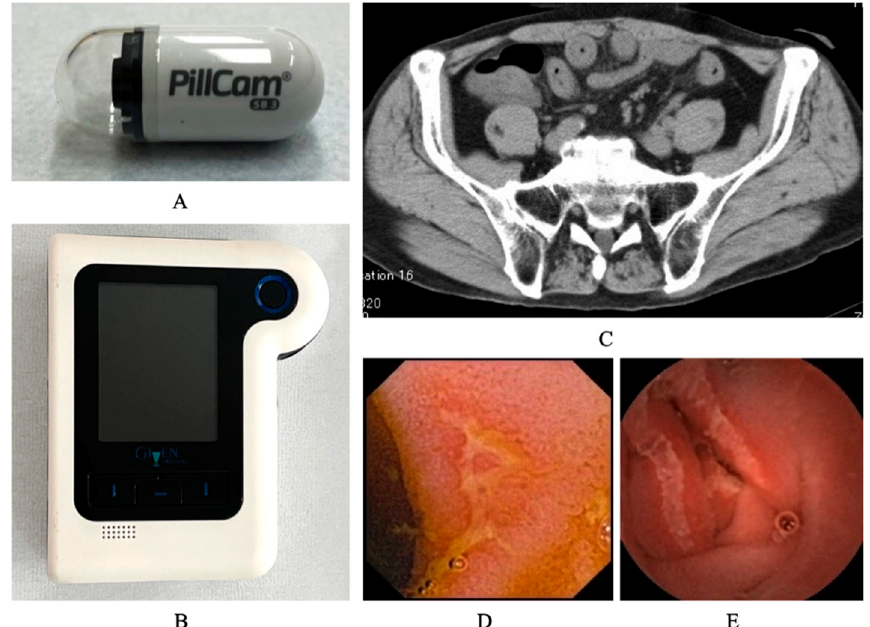
Figure 1. Images of capsule endoscopy of small intestinal mucosal injuries. The system of capsule endoscopy for CID contains the following elements: the capsule ( A ) and data recorder ( B ). SBCE imaging data were analyzed using reading software. CT scan suggested wall thickness of small intestine ( C ), and capsule endoscopy revealed small intestinal mucosal injuries with redness ( D ) and ulcers ( E ) in patient with CID.